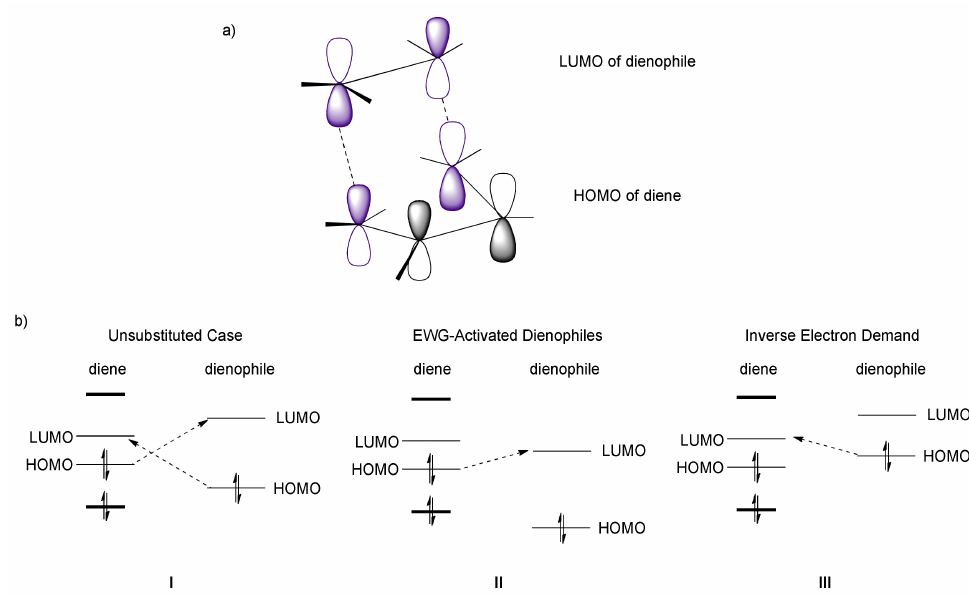
Figure 3. ( a ) Representation of HOMO and LUMO in the DA transition state and ( b ) types of FMO interactions. ( I ) standard HOMO–LUMO interaction, comparable energies; ( II ) HOMO of the diene interacts with LUMO of the dienophile; ( III ) LUMO of the diene interacts with HOMO of the